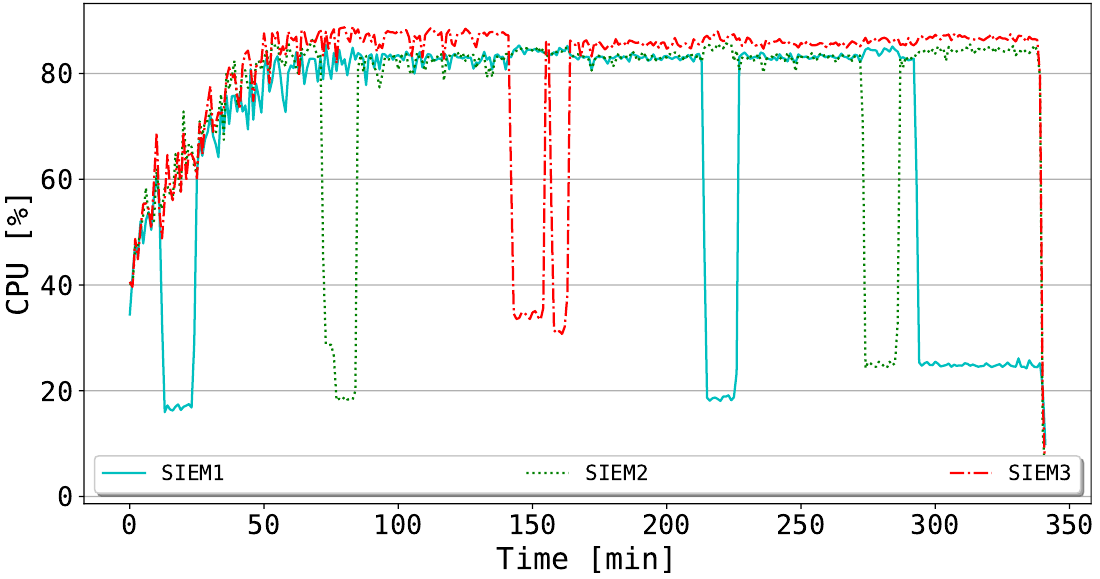
Figure 8. CPU utilization for the different SIEMs during drops and successive reactivations.